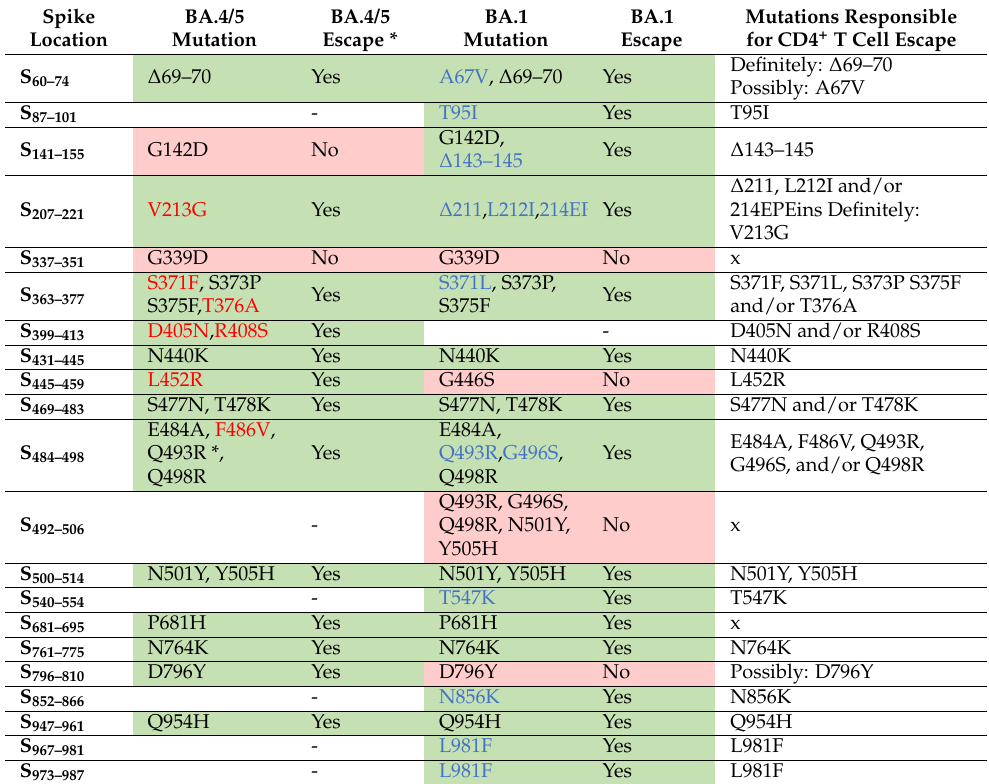
Table 2. List of BA.1 and BA.4/BA.5 mutations that can be responsible for partial or complete CD4+ T cell